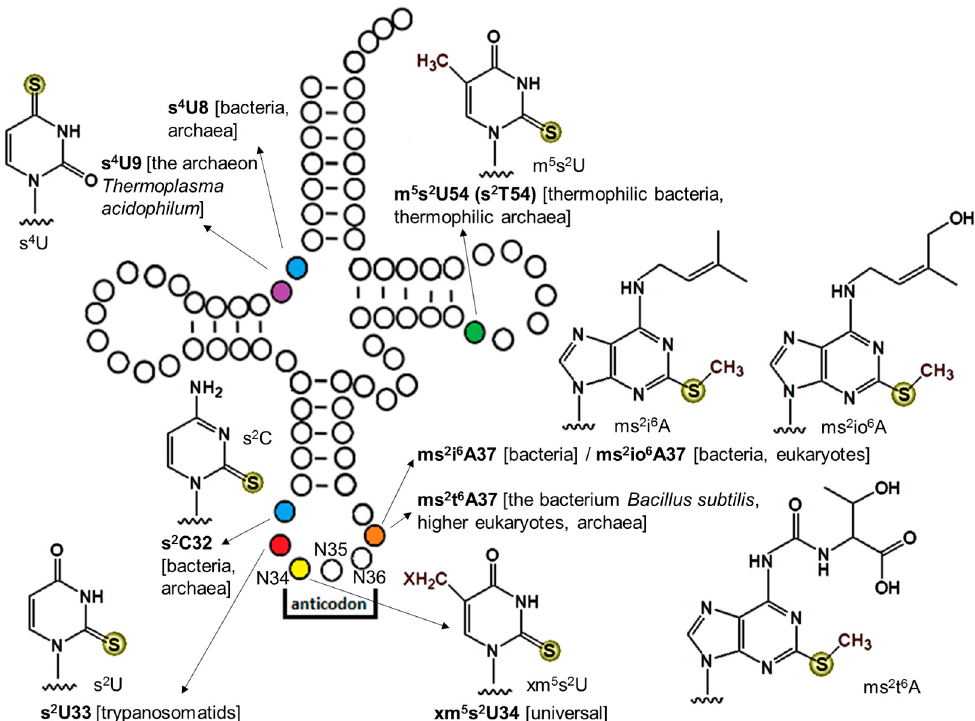
Figure 1. The location and structure of known tRNA thio ‐ modification in three domains of life. The distribution of each modification is indicated in square brackets. Abbreviations: s 4 U, 4 ‐ thiouridine; s 2 C, 2 ‐ thiocytidine; s 2 U, 2 ‐ thiouridine; m 5 s 2 U, 5 ‐ methyl ‐ 2 ‐ thiouridine; s 2 T, 2 ‐ thioribothymidine; ms 2 i 6 A, 2 ‐